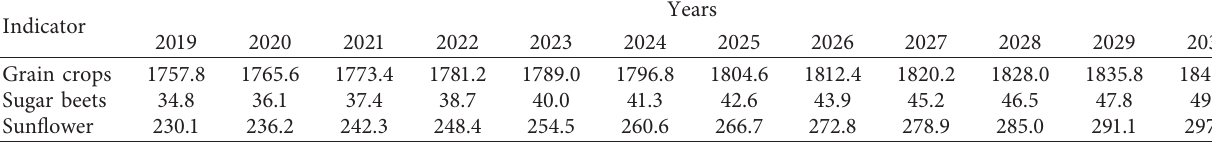
Table 2: Predicted values of sown area agricultural crops, thousand